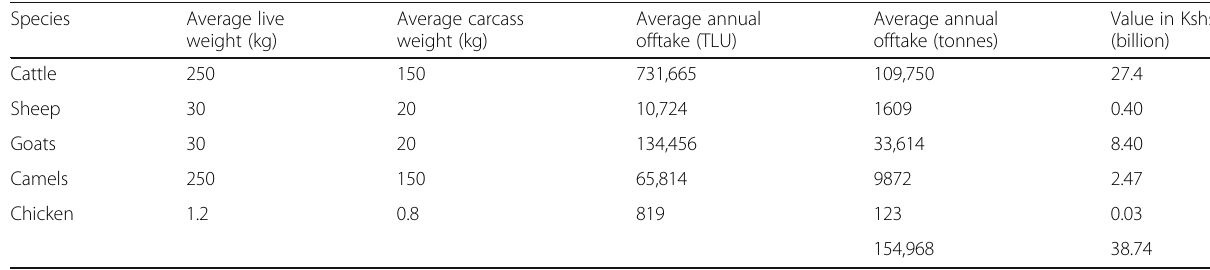
Average carcass weight (kg)